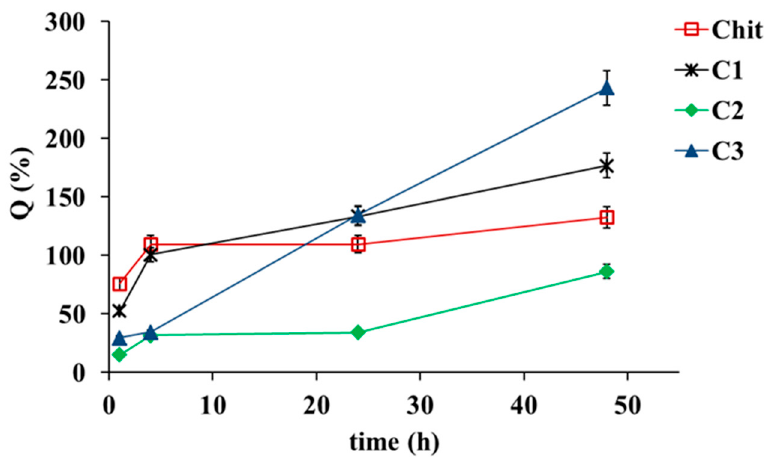
Figure 3. Swelling ratio of Chit films and its composite films, n = 3, mean ± SD (standard deviation), error bars represent SD.